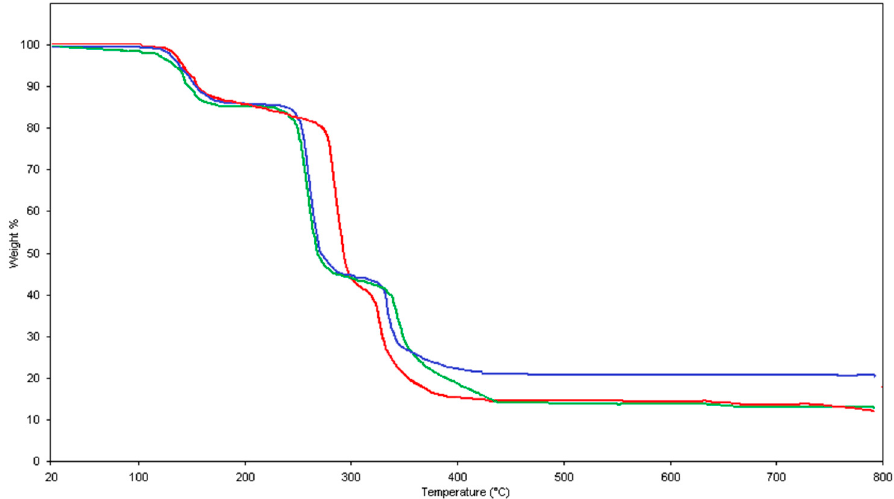
Figure 1. Thermally induced releasing profiles of the Cu(H 2 PIDC) 2 (H 2 O) 2 (blue curve), Cd(H 2 PIDC) 2 (H 2 O) 2 (red curve), and Zn(H 2 PIDC) 2 (H 2 O) 2 (green curve): Air flow at 100 mL min − 1 ; heating rate 5 °C min − 1 .